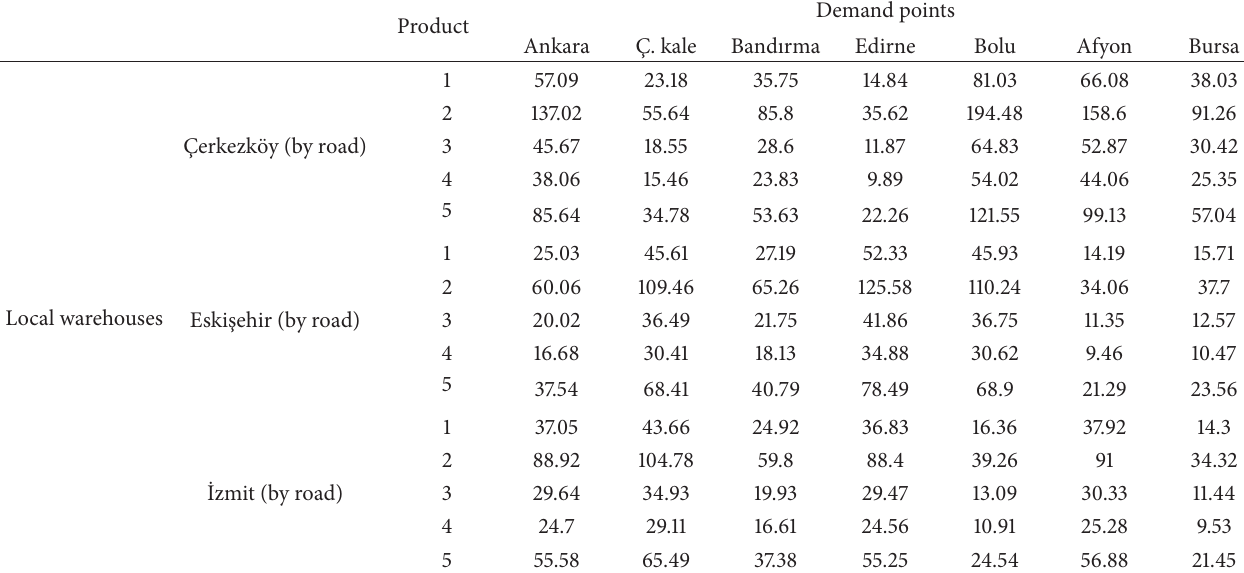
Table 8: Transportation costs from local warehouses to demand points (TL/product).